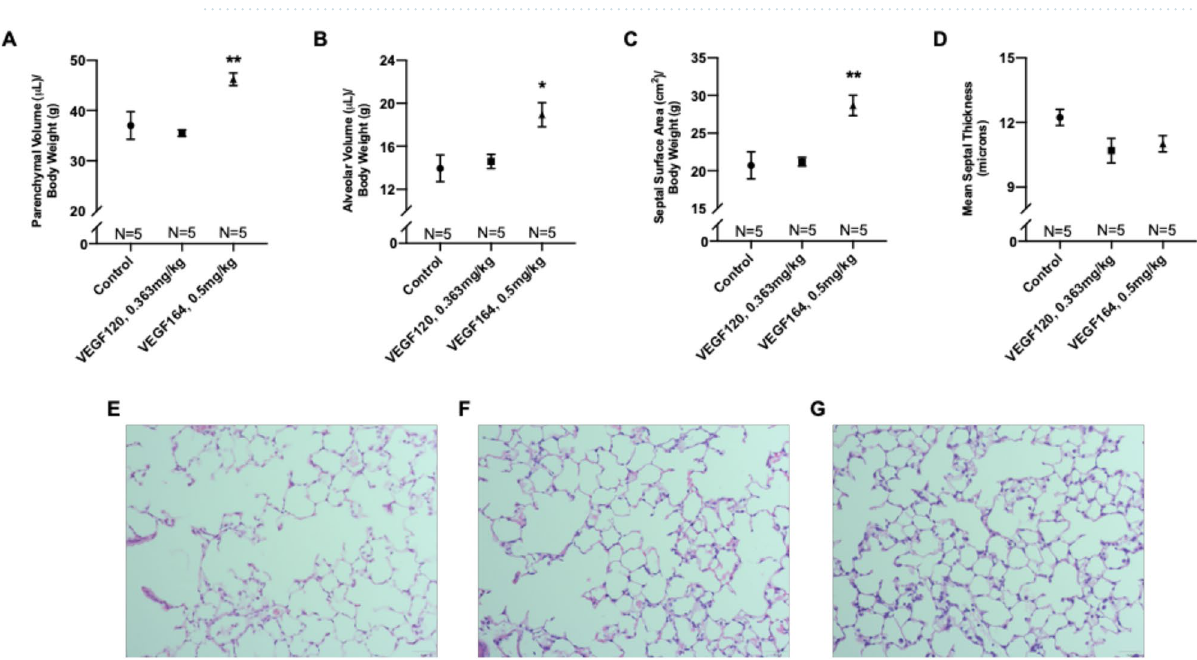
Figure 2. Morphometric analysis of lung tissue. VEGF164-treated mice exhibited significant increases in parenchymal volume ( A ), alveolar volume ( B ), and septal surface area ( C ), while VEGF120 did not. VEGF treatment also decreased mean septal thickness, although this did not reach statistical significance (D). Representative micrographs at × 200 magnification of hematoxylin and eosin-stained, control ( E ), VEGF120 ( F ), and VEGF164 ( G ) lung sections demonstrate increased alveolarization with VEGF164 treatment ( G ). Statistical analysis of morphometrics was performed by ANOVA with Holm-Sidak correction for multiple comparisons. Results are expressed as mean ± SE. *P < 0.05. Results are expressed as mean ± SE. *P < 0.05, **P <